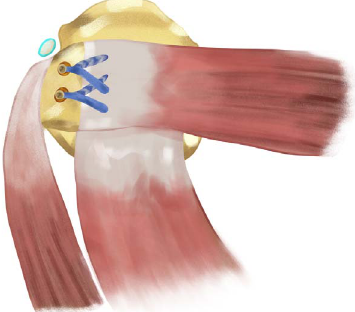
Figure 4. Axial scheme of the latissimus dorsi tendon transfer. The LD tendon is transferred to previously prepared footprint to restore external rotation and provide vertical stability of humerus in massive rotator cuff